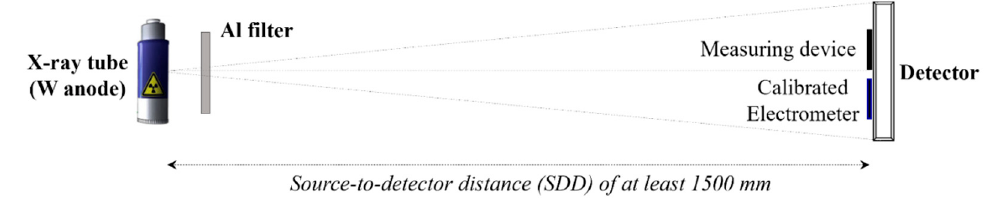
Figure 1. X-ray system for the experimental study, which mainly consists of an X-ray tube (E7252X, Toshiba, Kabushikigaisha, Japan), and the detectors (FXRD-4343VAW, FXRD-4343VAW Plus,